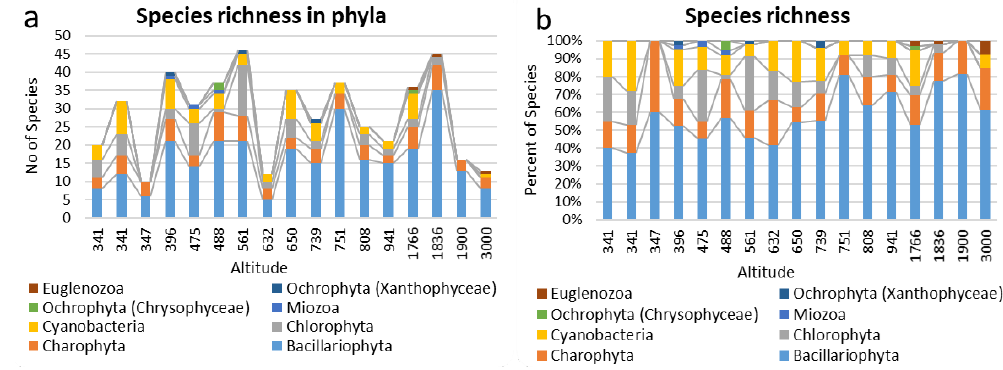
Figure 6. Dynamic of species richness in taxonomic phyla in the communities of the studied sites. Number of species in phyla ( a ); percent of species in phyla ( b ).